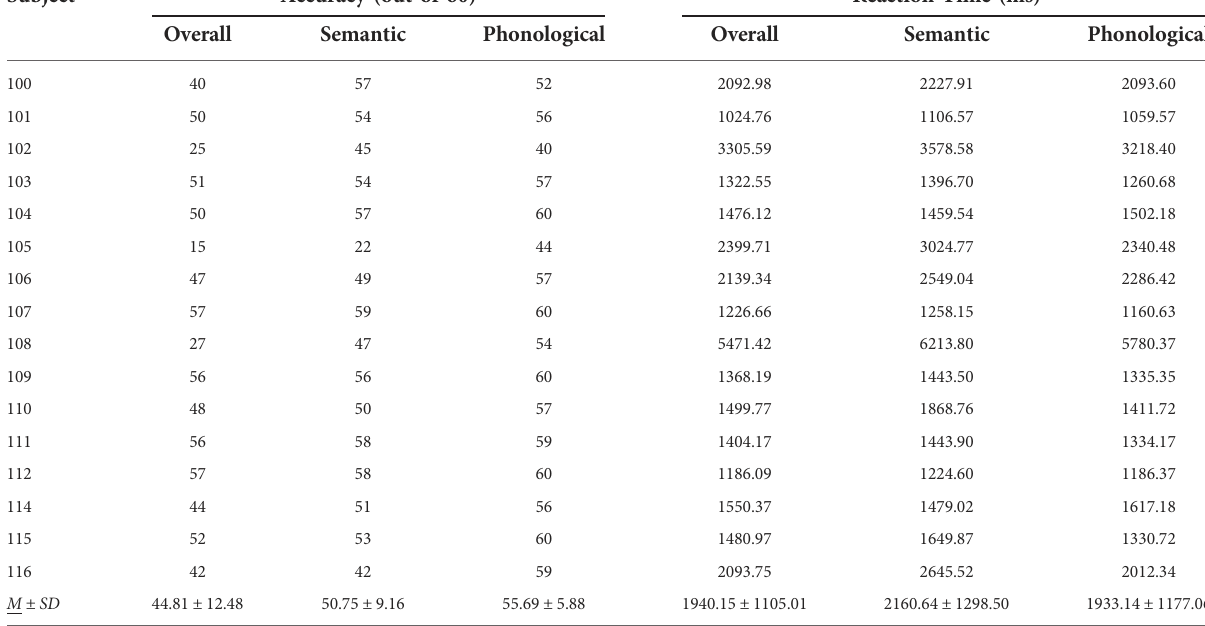
TABLE 4 rWPVT raw accuracy and mean response latency